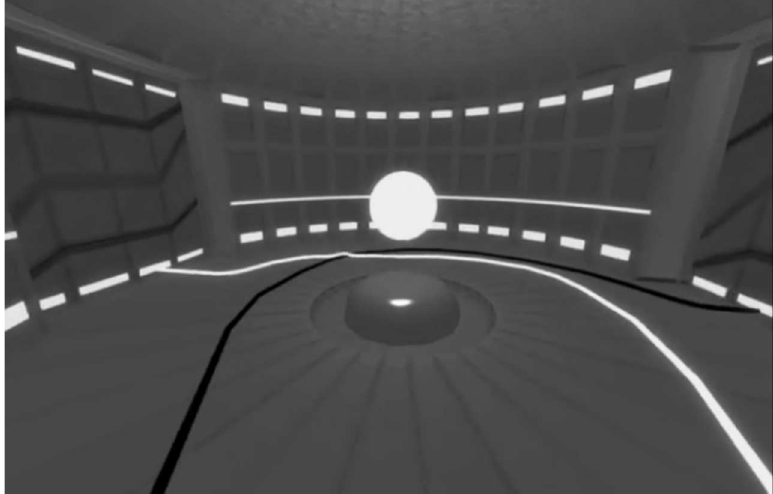
Figure 5. Interface of the Colorblind Maze game (source: own work)